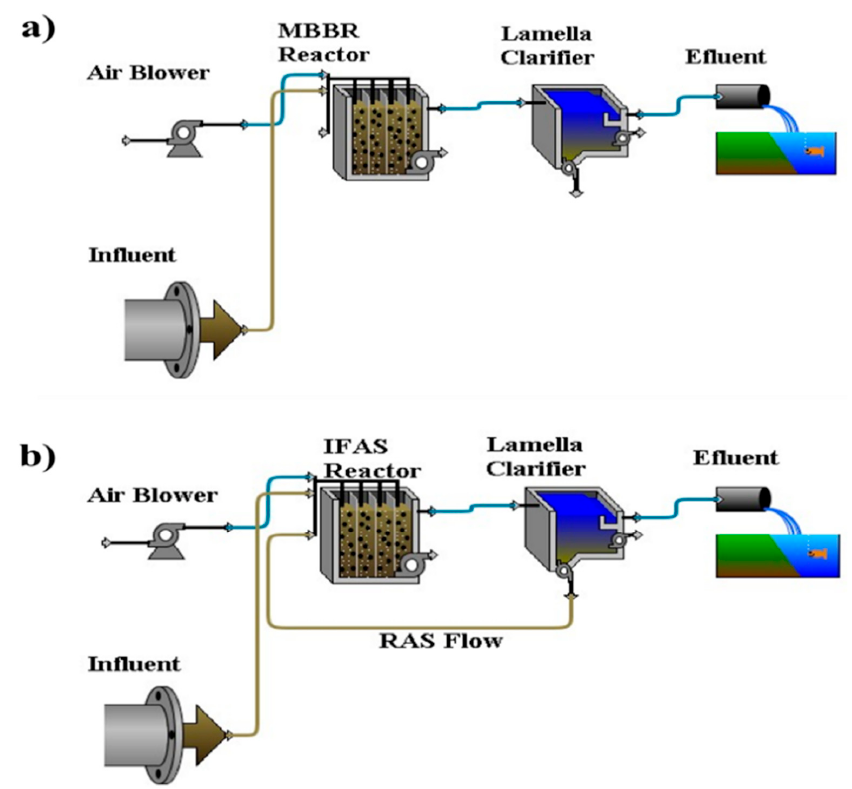
Figure 1. The schematic design of the: ( a ) MBBR system and ( b ) IFAS system. Table 1. System design parameters.